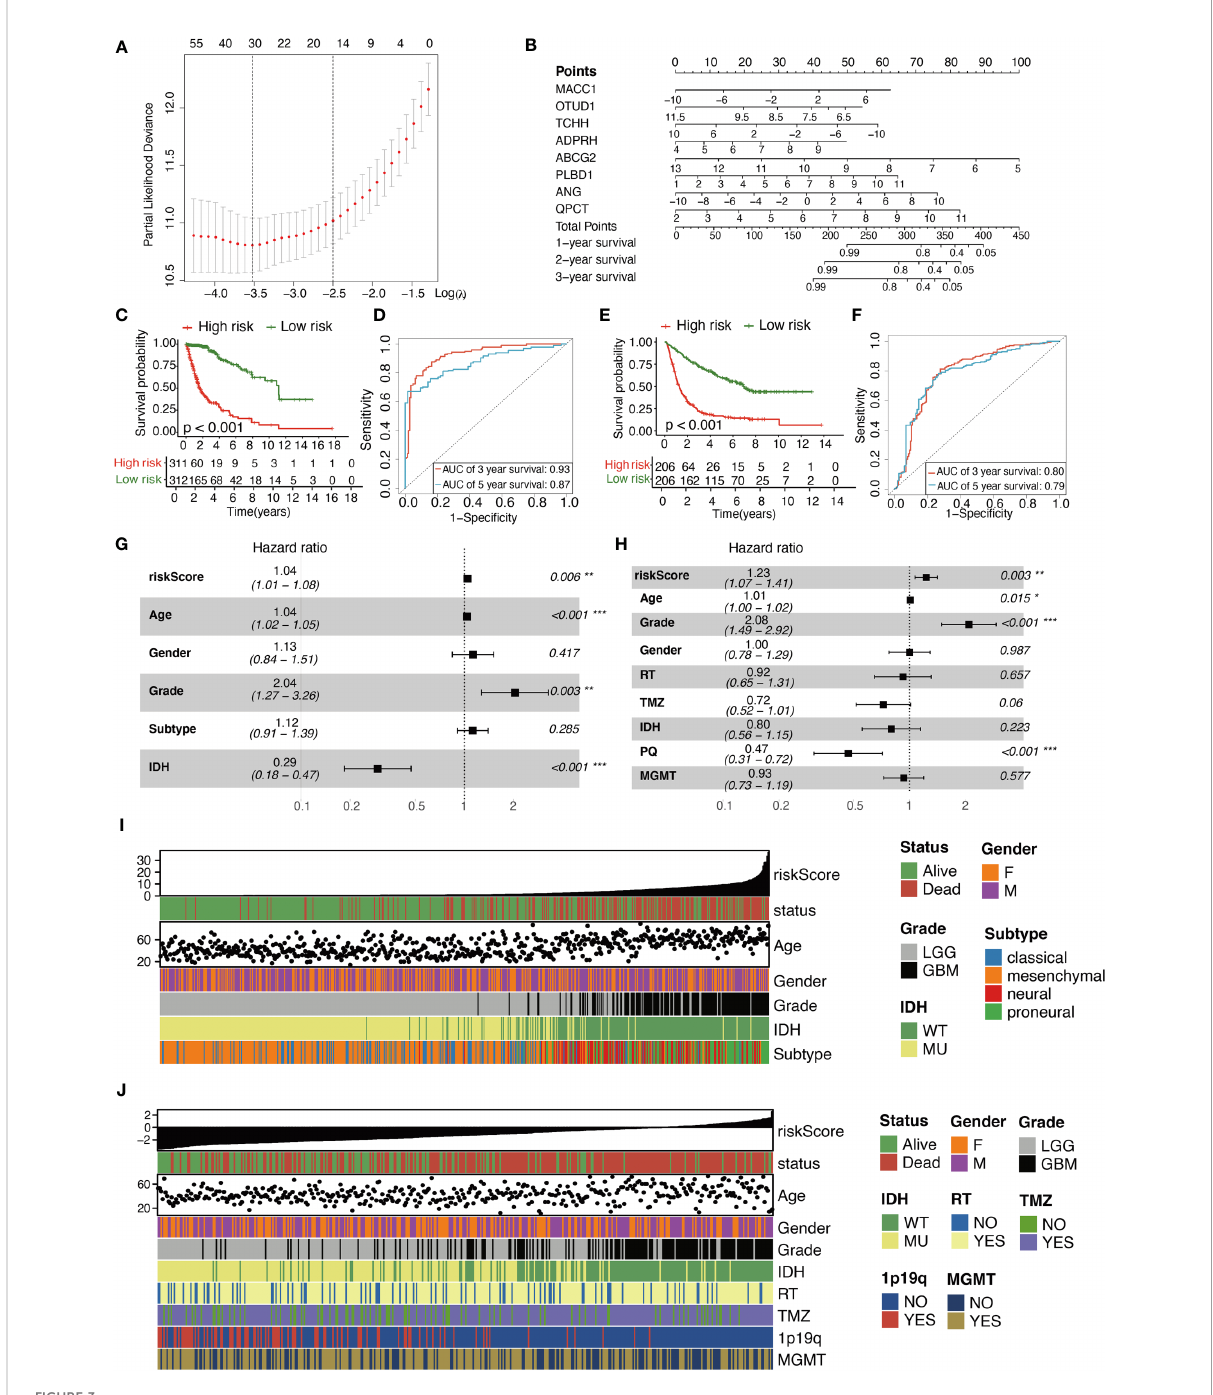
FIGURE 3 Characterization of the signature predicts prognosis of glioma. (A) Texture feature selection using the LASSO regression model, lambda value was chosen (1-SE criteria) according to cross-validation, where optimal l resulted in six non-zero coef fi cients in the training cohort. (B) Nomogram to predict the 1-, 2-, 3-year OS. Kaplan – Meier curve based on the predictive model in TCGA cohort (C) and CGGA cohort1 (E) . ROC curves of the signature for predicting 3- and 5- year survival of glioma in both TCGA cohort (D) and CGGA cohort1 (F) . (G, H) Multivariable comparison of clinical features and the risk score. Subtype includes classical (reference), mesenchymal, neural, proneural. Risk score is correlated with clinicopathological features and prognosis of glioma in TCGA cohort (I) and CGGA cohort1 (J) . IDH, isocitrate dehydrogenase; RT, radiotherapy; TMZ, temozolomide; 1p19q, 1p/19q codeletion status; MGMT, methylguanine methyltransferase. *P < 0.05, **P < 0.01, ***P <